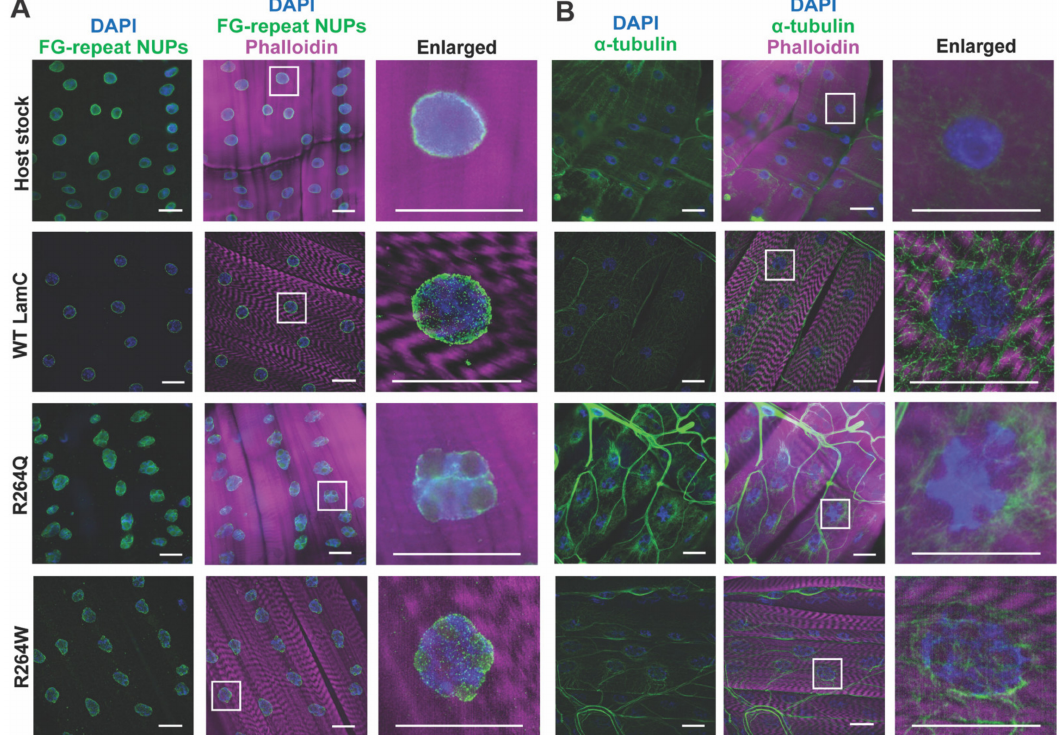
Figure 6. Nuclear deformation caused by expression of the LamC R264Q and R264W transgenes altered nuclear pore distribution, but not nuclear microtubule caging. ( A ) Larval body-wall muscles expressing endogenous LamC host stock and either a wild-type or mutant LamC transgene were fixed and stained with phalloidin (magenta), DAPI (blue) and antibodies to FG-repeat containing nuclear pore proteins (NUPs) (green). The scale bar represents 30 µ m. ( B ) Larval body-wall muscles were fixed and stained with phalloidin (magenta), DAPI (blue) and antibodies to a-tubulin (green). The scale bar represents 30 µ m. Lamins interact with nuclear pore proteins [26,27]. Therefore, we stained larval body wall muscles expressing wild-type and mutant LamC with antibodies that recognize FG-repeat containing nuclear pore proteins (NUPs) (Mab414; Covance). In muscles expression of wild-type LamC , the nuclear pore proteins were distributed evenly within the nuclear envelope ( A ). By contrast, muscles expressing the R264Q and R264W transgenes showed areas of concentration at the nuclear